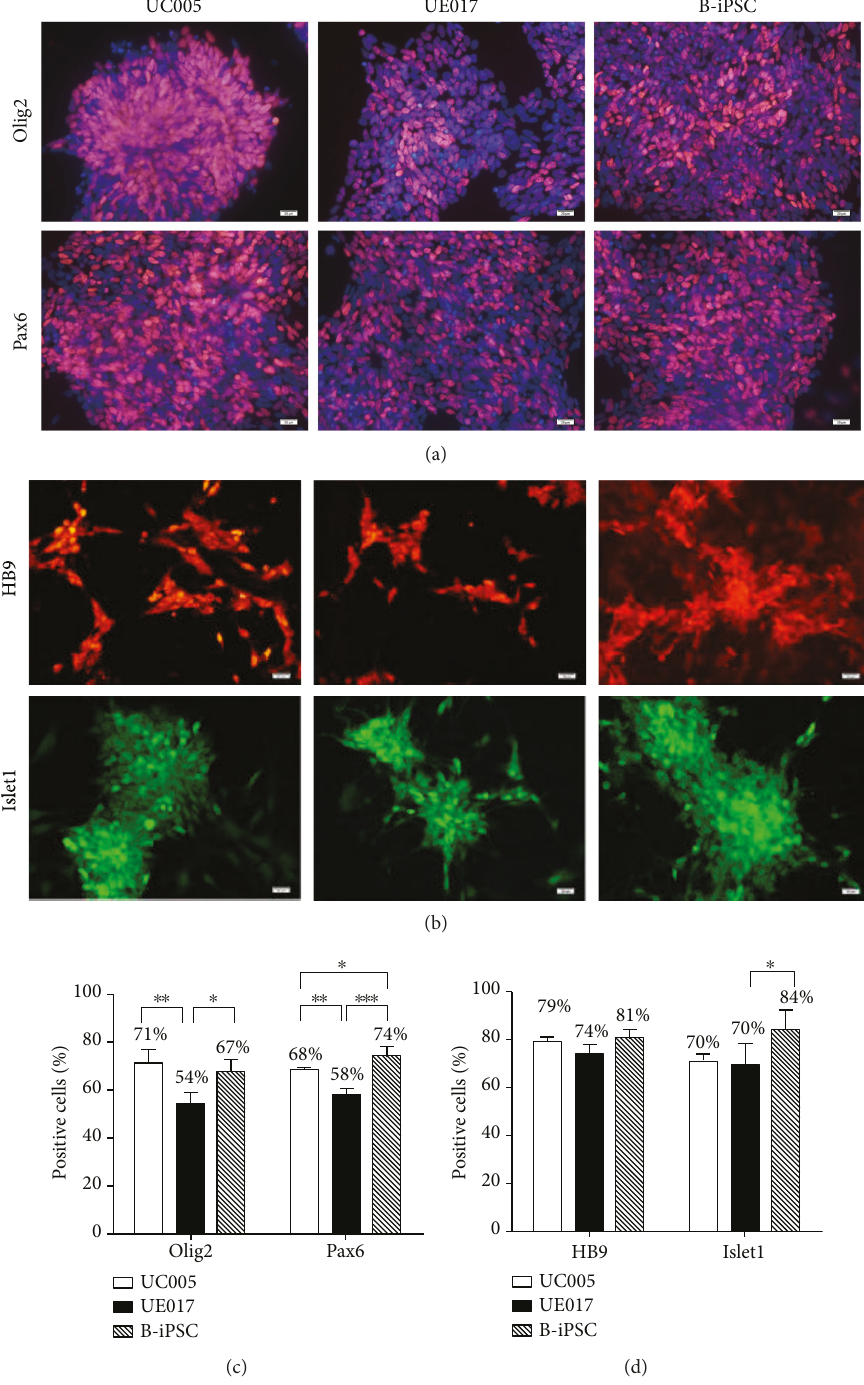
Figure 5: Immunocytochemical staining and ratios of positive labeling of the MNPs and MNs. (a) After 13 days of induction, cells derived from all three iPSC lines, UC005, UE017, and B-iPSC, were positive for the MNP markers, Olig2 and Pax6. Cell nuclei were counterstained with 4 ′ ,6-diamidino-2-phenylindole (DAPI). The scale bar is 50 μ m. (b) After 19 days of induction, the cells derived from all three iPSC lines, UC005, UE017, and B-iPSC, were positive for the MN markers, HB9 and Islet1. Cell nuclei were counterstained with 4 ′ ,6-diamidino-2- phenylindole (DAPI). The scale bar is 50 μ m. (c) Cells from the UC005 and B-iPSC lines expressed higher levels of the MNP markers than the cells from the UE017 line. (d) The ratios of positive labeling for HB9 and Islet1 in MNPs after 19 days of induction. The ratios of positive labeling for HB9 were 79%, 74%, and 81% in MNs derived from UC005, UE017, and B-iPSC, respectively, but the di ff erence was not statistically signi fi cant. A total of 84% of MNs from B-iPSC expressed Islet1, which was signi fi cantly higher than that of MNs from UC005 and UE017. The ratio of positive labeling (%)=(number of positive cells/total number) × 100%. ∗∗∗ P < 0 0001 , ∗∗ P < 0 001 , and ∗ P < 0 01 according to Student ’ s t